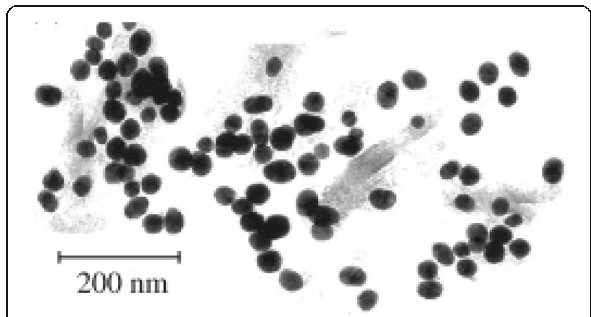
Fig. 3 A TEM image of the nanoparticles synthesized by Rudakovskaya et al. As can be seen, the nanoparticles are roughly spherically shaped with an average size of 30 nm [76]